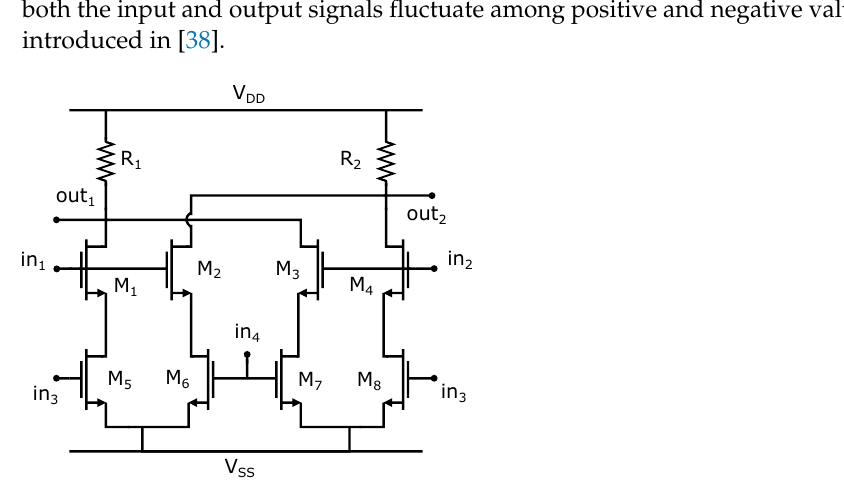
Figure 11. Fully differential four-quadrant multiplier taken from [38].